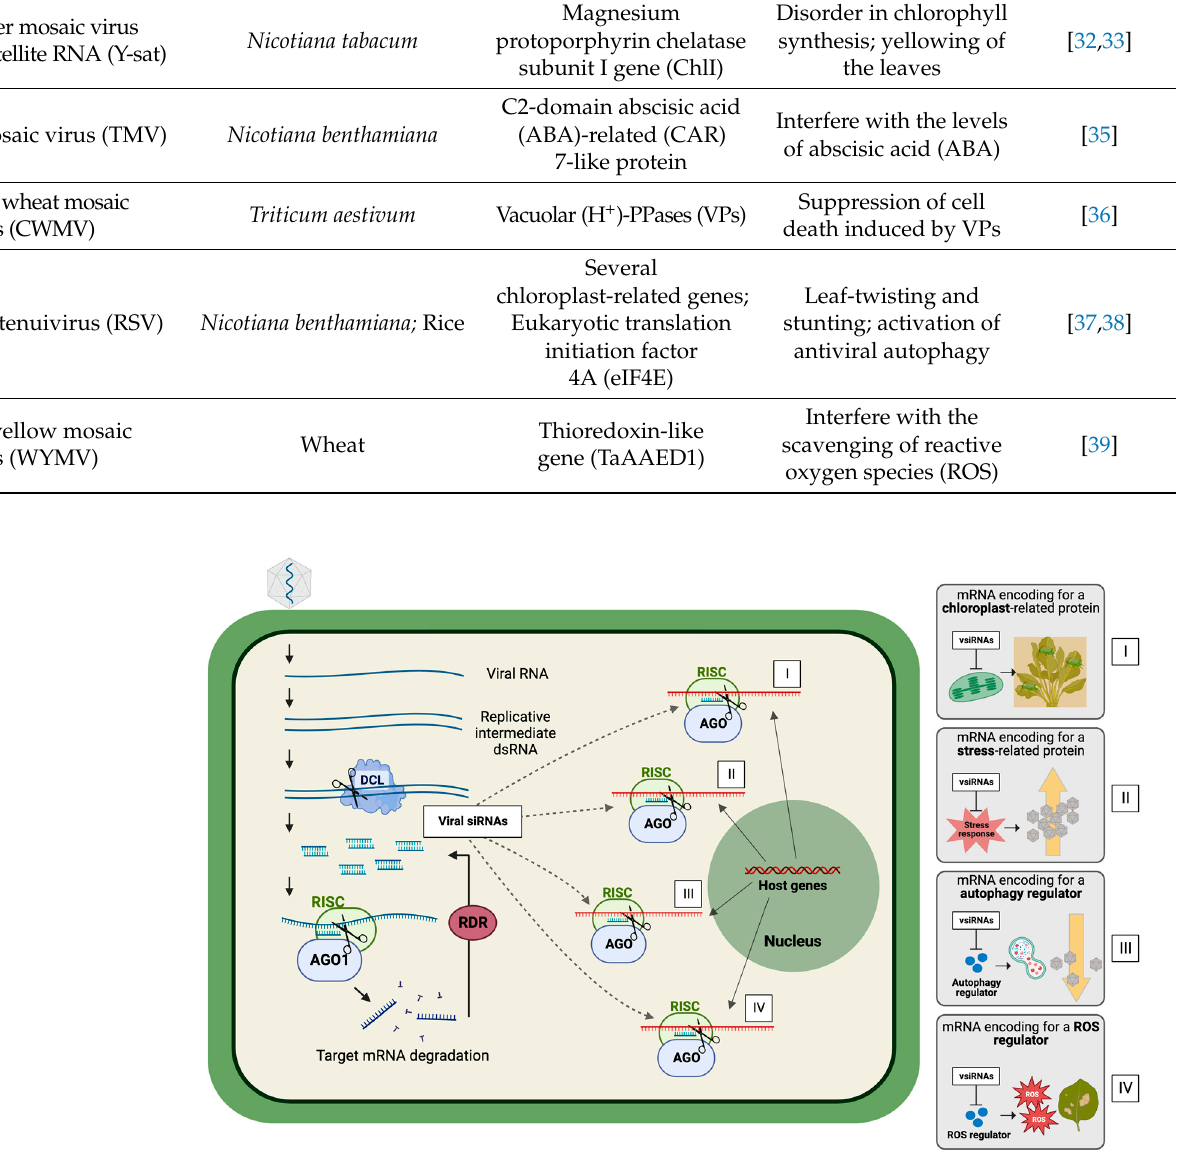
Figure 1. Implicated roles of virus-derived siRNAs (vsiRNAs) in plant–RNA virus interaction. During antiviral RNA silencing, generated vsiRNAs not only target the virus genome but can also modulate the expression of host genes. In the case of RNA virus infection (represented in this figure), viral replicative intermediate double-stranded RNAs (dsRNAs) are processed by Dicer-like proteins (DCL) into ~ 21 nucleotide (nt) primary vsiRNAs. These vsiRNAs can be loaded into AGO1 to form an active RNA-induced silencing complex (RISC) that mediates the silencing of the respective virus genome (left). Plant RDR proteins are involved in the generation of secondary vsiRNAs. Both primary and secondary vsiRNAs can be loaded into different AGOs for the amplification of RNA silencing. Plant virus-derived siRNAs may also act in trans to modulate the viral–host interplay when functional vsiRNAs, exhibiting complementarity to host genes, are loaded into the RNA silencing complex, change host gene expression and, consequently, affect different plant biological processes, depending on the nature of the host target mRNAs (panels at the right hand side). For example: (I) silencing of chloroplast-related genes by vsiRNAs may induce symptoms such as yellowing of the leaves, turning plants more attractive to insect vectors; (II) silencing of stress-related genes may lead to increased susceptibility of the host to virus infection; (III) silencing of important regulators of autophagy may activate the antiviral autophagy mechanism that inhibits viral infection; and (IV) silencing of ROS regulators may amplify ROS signaling that promotes cell death. 3. Virus-Activated Plant Endogenous Small RNAs as Modulators of Virus–Plant Inter- actions The activation of antiviral RNAi during plant viral infections not only triggers the accumulation of vsiRNAs, but it is also accompanied by the production of plant endoge- nous sRNAs (including viral activated vamiRNAs and vasiRNAs) with modulating ef- fects on the host to support the establishment and maintenance of virus infections or, in some cases, to activate antiviral host defense mechanisms [57]. Viral infections can alter plant endogenous sRNAs at the transcriptional level [58], or may interfere with their pro- cessing/biosynthesis [59]. One of the first identified pathogen-induced host endogenous siRNAs involved in the regulation of plant immunity/defense against the pathogen was reported during a study on the bacterial pathogen Pseudomonas syringae pv. tomato (Pst) DC3000 [60]. The reported nat-siRNAATGB2 is specifically induced by the effector avrRpt2 from Pst DC3000 and represses its antisense target PPRL (pentatricopeptide repeats protein-like) gene, a negative regulator of the (avrRst2-triggered) RPS2-mediated resistance response. The first studies on endogenous host sRNAs activated upon virus infection started to appear after the turn of the millennium in 2000. One of the first papers reporting on this